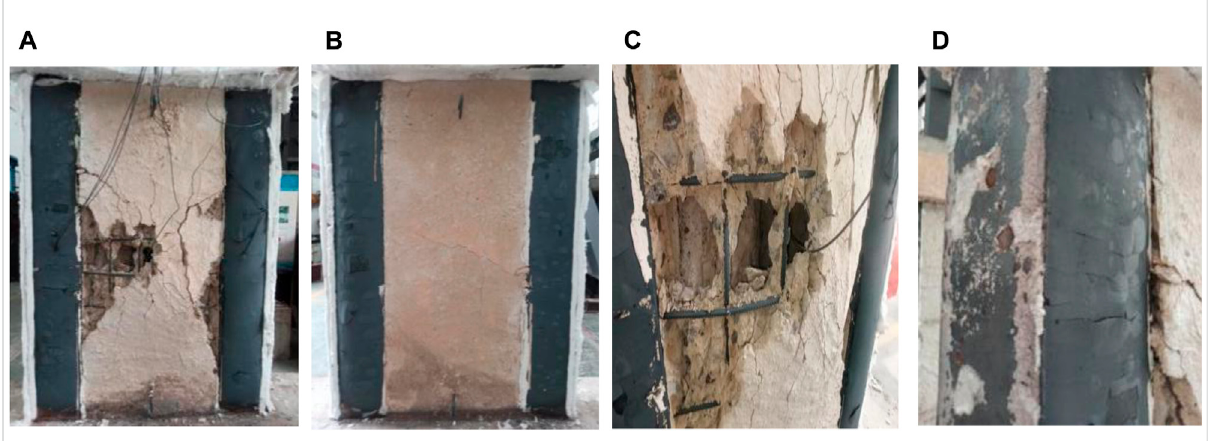
FIGURE 7 SpecimenSW1after fi retest: (A) front; (B) back; (C) strippingofconcreteinthewallandexposedreinforcingsteel; (D) bucklingoftheconcealed column steel tube and oxidation layer on the steel tube